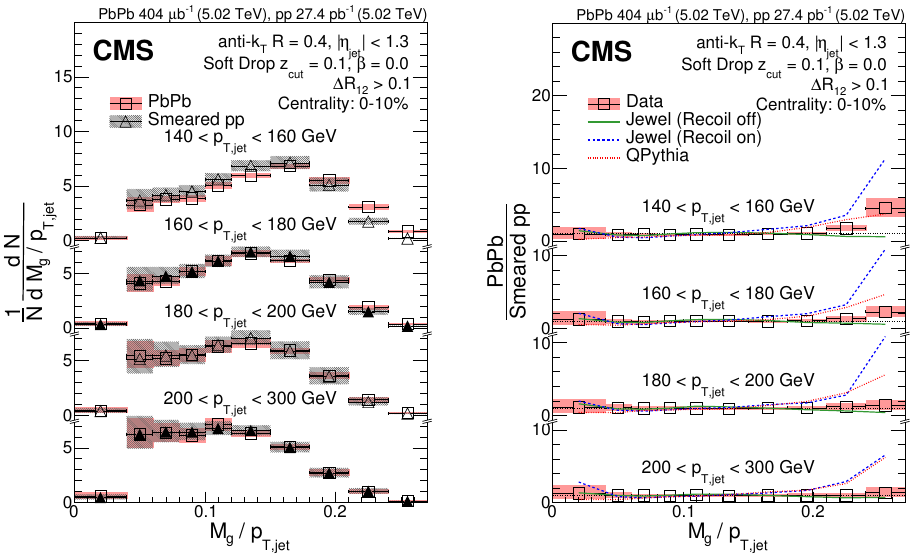
Figure 5 . (left) The p jet dependence of M g =p jet , for PbPb events in the centrality class 0{10%, T T for the (0 : 1 ; 0 : 0) SD setting. Results are compared to the smeared pp spectra. (right) The ratio of PbPb data over smeared pp data. The heights of the colored boxes indicate systematic uncertainties. Statistical uncertainties are less than the marker sizes. The ratios are compared to smeared jewel and q-pythia generators, shown in blue and green, respectively.